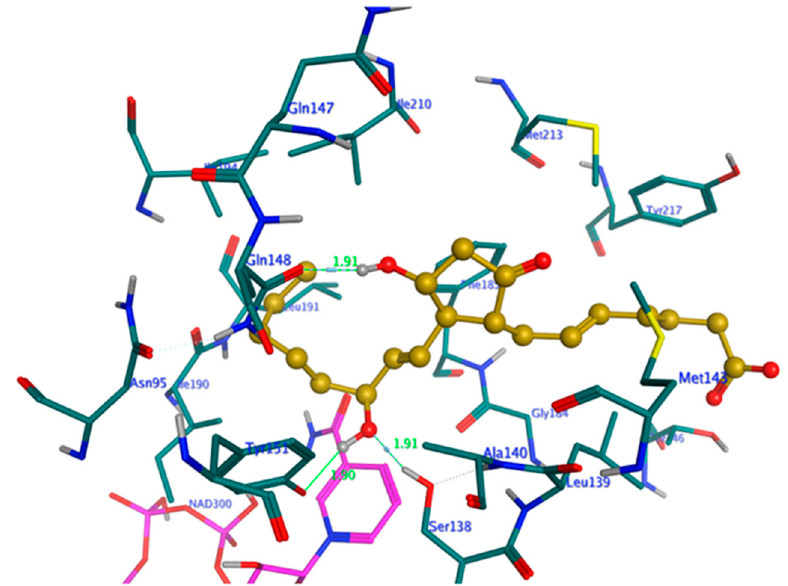
Figure 1. PGE2 docked pose showing H-bonding interactions Ser138, Tyr151, and Gln148. Also shown are residues within 3.5 angstroms of PGE2. The C2-C7 alkyl chain, as well as the C16-C20 alkyl chain of PGE2, are predominantly surrounded by hydrophobic residues. PGE2 is shown in